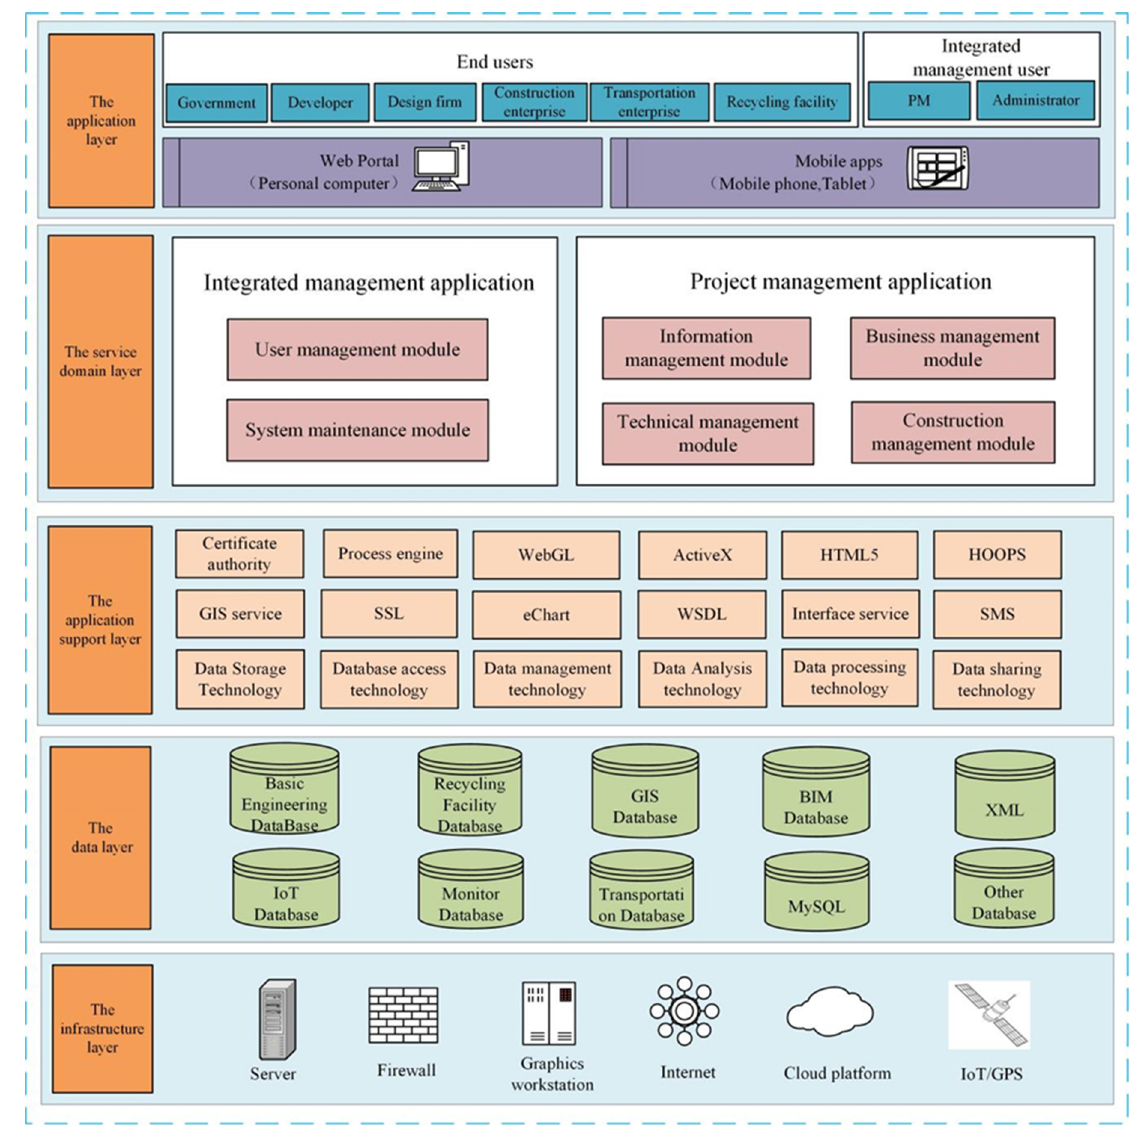
Figure 1. The overall framework of the BIM-GIS-IoT-based excavated soil recycling system.